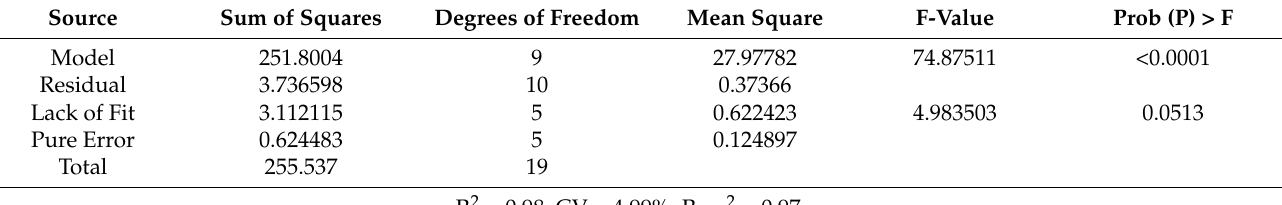
Table 3. ANOVA of quadratic model.